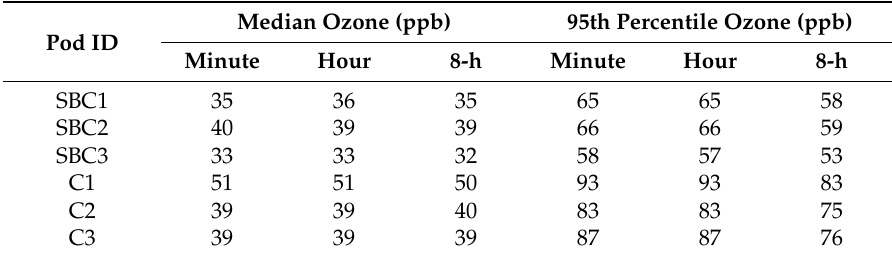
Table 3. Median and 95th Percentile Ozone for Minute, Hour, and 8-H Averaged Deployment Data.